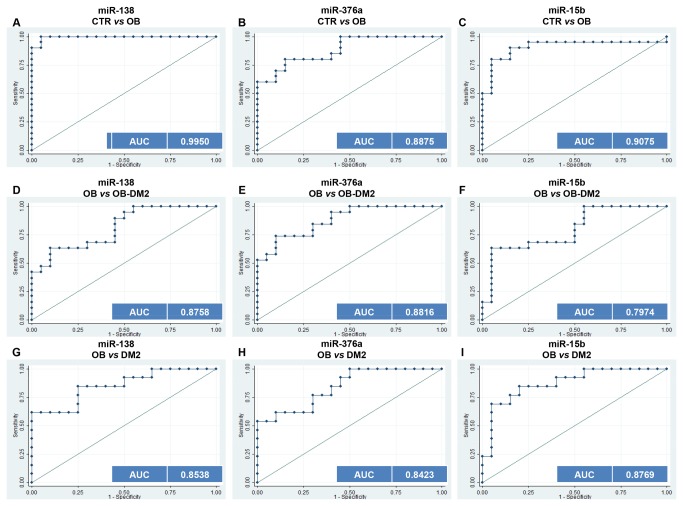
ROC curves to compare the ability of each miRNA to distinguish between different groups.(A) miR-138, (B) miR-376a and (C) miR-15b can distinguish between OB and CTR. (D) miR-138 (E) miR-376a (F) miR-15b can also distinguish between OB and OB-DM2. (G) miR-138 (H) miR-376a (I) miR-15b can distinguish between OB and DM2.